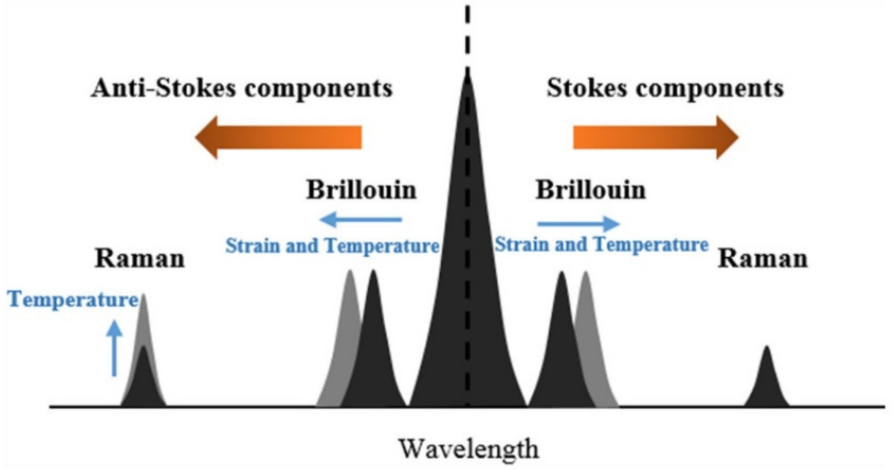
Figure 13. Illustration of the different frequency components in a signal due to Rayleigh, Brillouin, and Raman scattering. Reprinted with permission from Ref. [85]. Copyright 2016 Measurement Science and Technology.